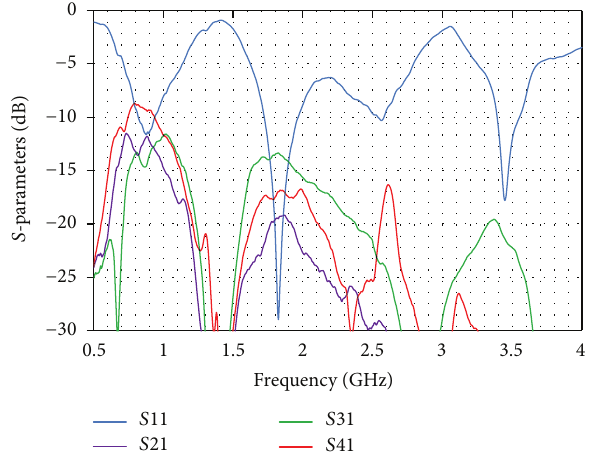
Figure 14: Measured 𝑆 -parameters of the prototype in the realistic test bed.